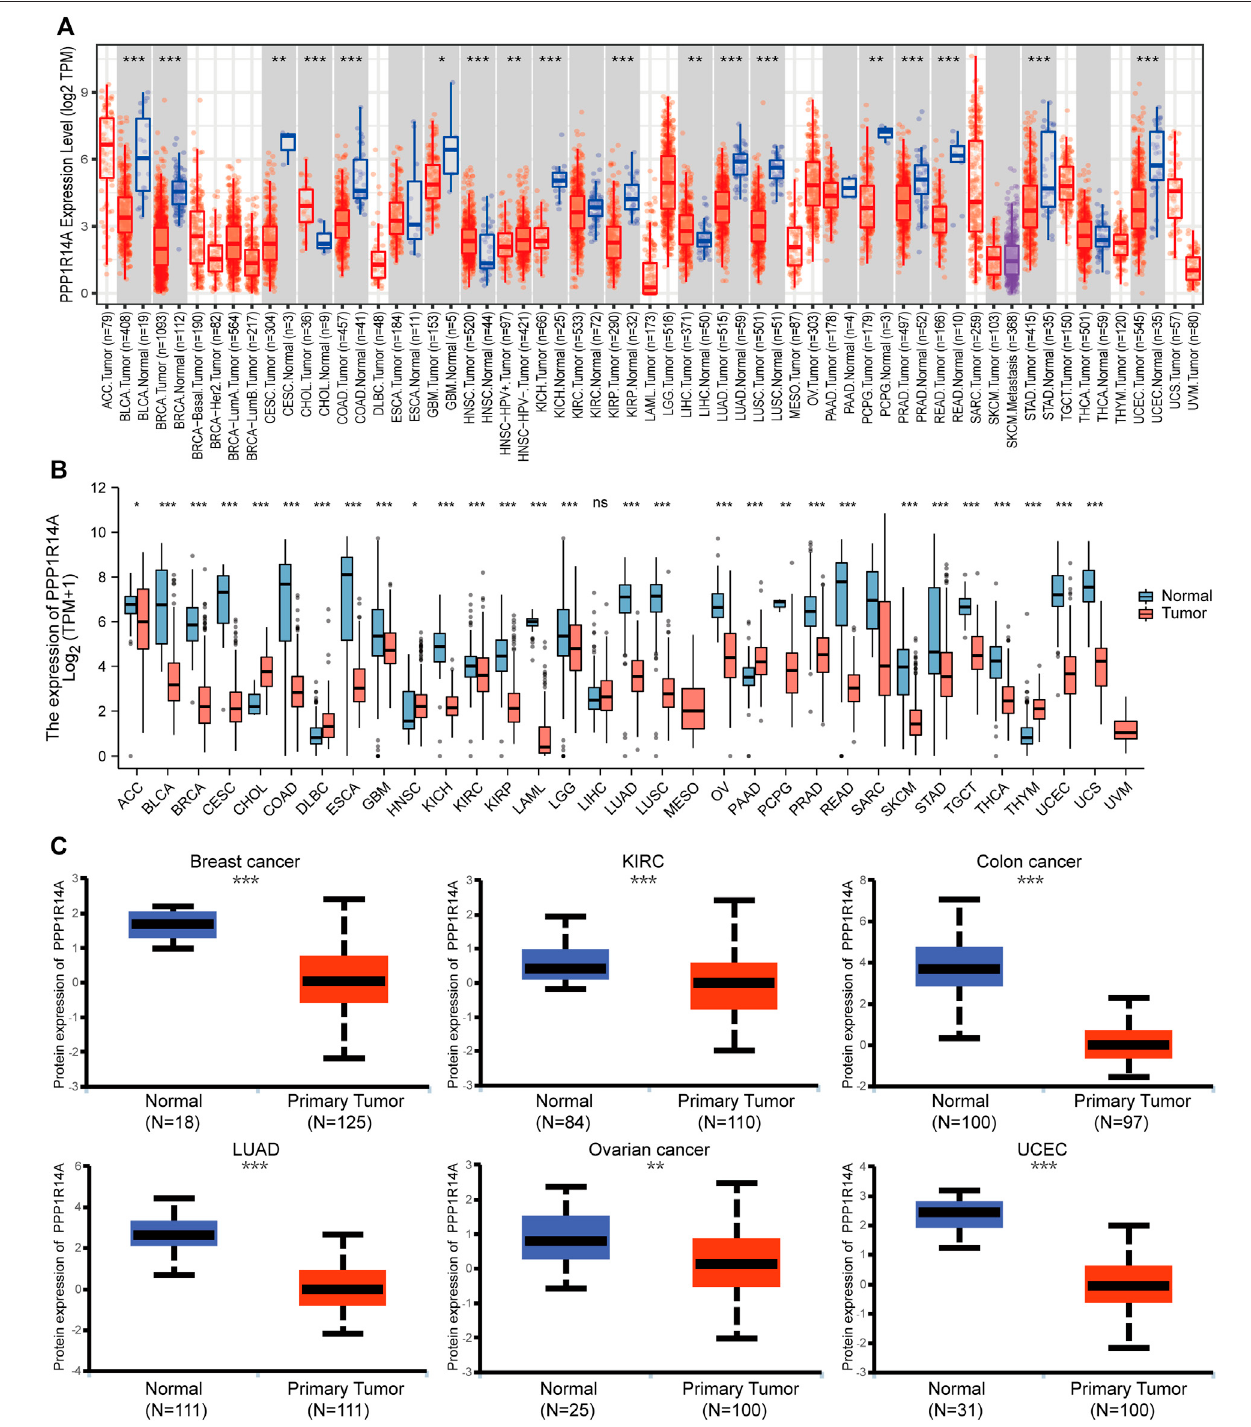
FIGURE 1 | Aberrant mRNA expression of PPP1R14A in pan-cancer from the TIMER2.0 database indicated that the PPP1R14A expression in 18 cancer types. The red and blue boxes represent tumor tissuesand normal tissues, respectively (A) . Expression level of PPP1R14A in different cancer types from TCGA and GTEx (B) . PPP1R14A protein expression level in normal tissues and primary tissues of breast cancer, KIRC, colon cancer, LUAD, ovarian cancer, and UCEC was examined using the CPTAC datasets (C) . ns, p ≥ 0.05; *, p < 0.05; **, p < 0.01; ***, p < 0.001.